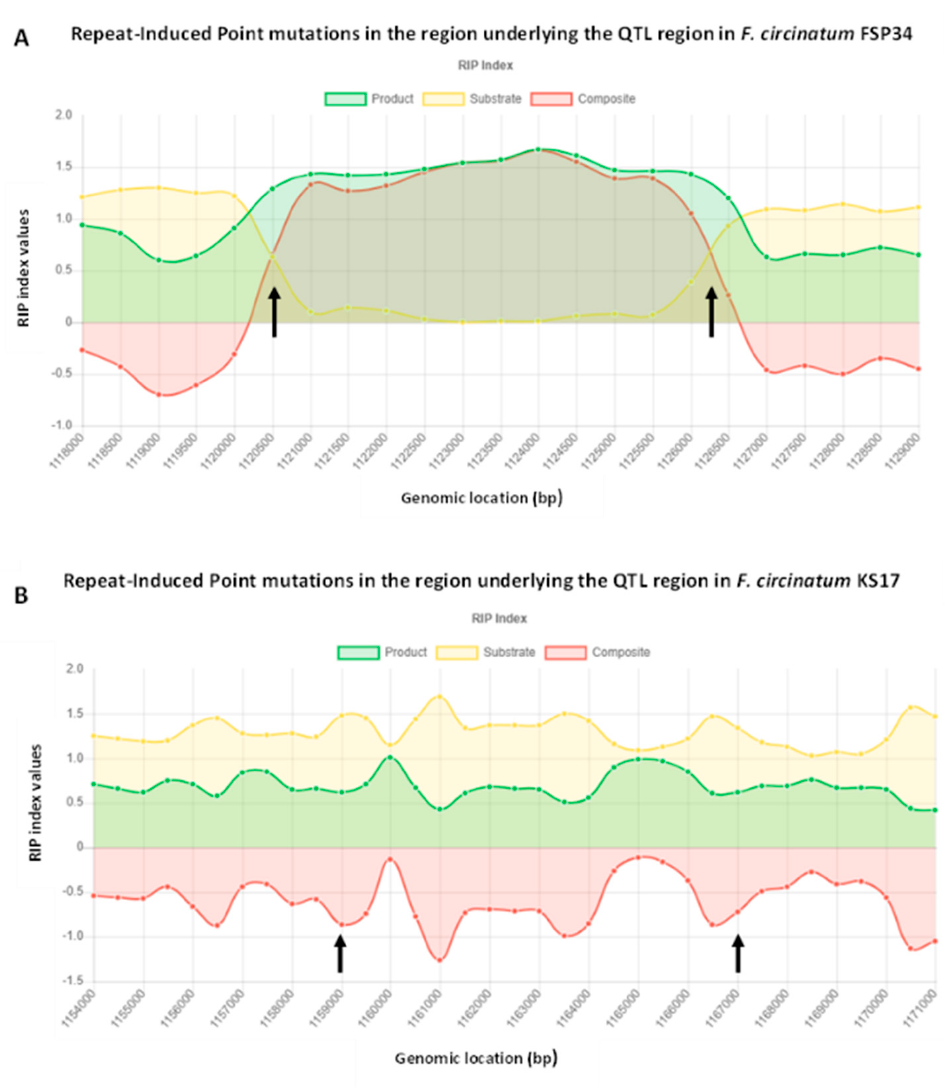
Figure 5. Graphs showing evidence of Repeat-Induced Point (RIP) mutations in the region underlying the QTL region of ( A ) F. circinatum FSP34 (indicated by the arrows) and ( B ) F. circinatum KS17, which is not affected by RIP. The graph was created in The RIPper online software tool [66] (https: //theripper.hawk.rock (accessed on 25 February